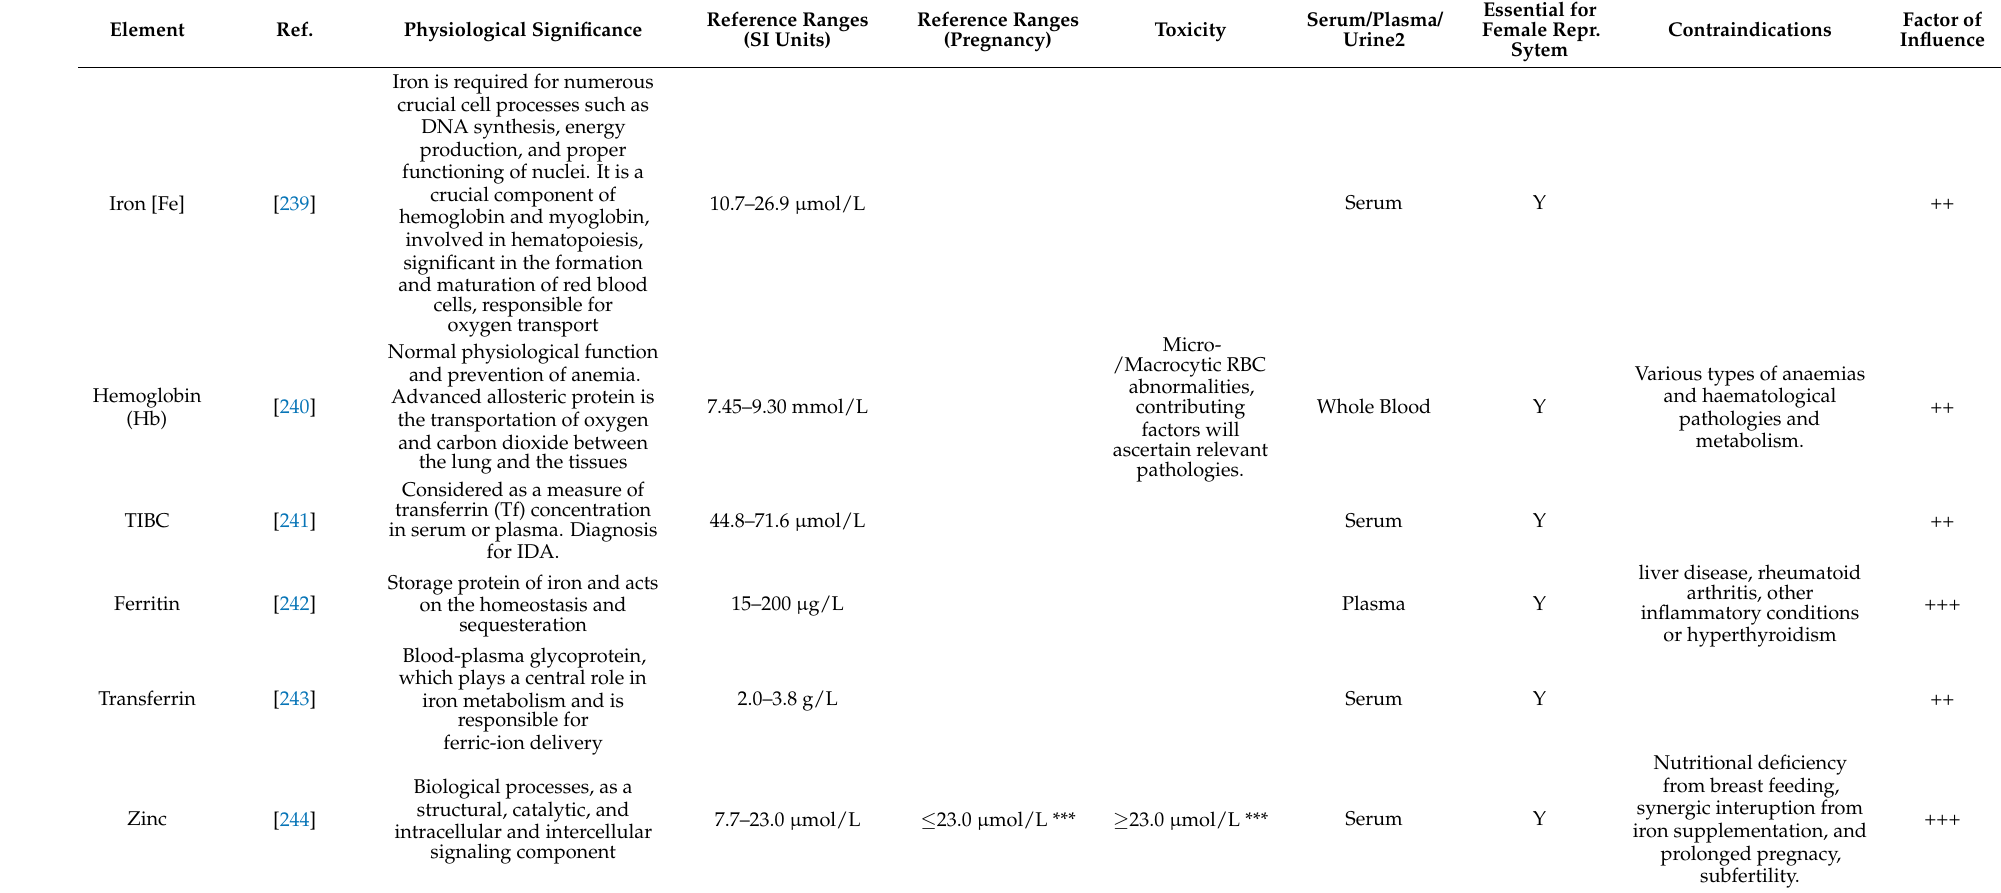
Table 2. Summary table regarding the concentration of trace elements and its significance in female reproductive system